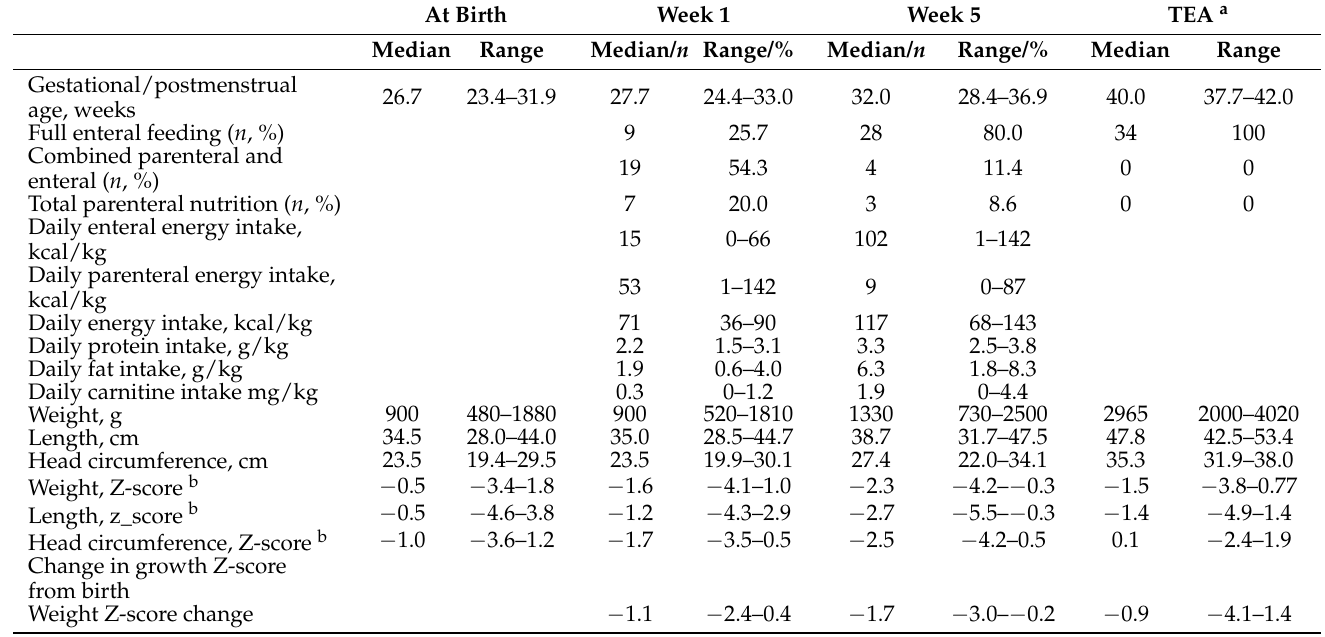
Table 2. Nutrition, carnitine intake, and longitudinal growth from birth to term equivalent age (TEA) and brain size at TEA in 35 very preterm